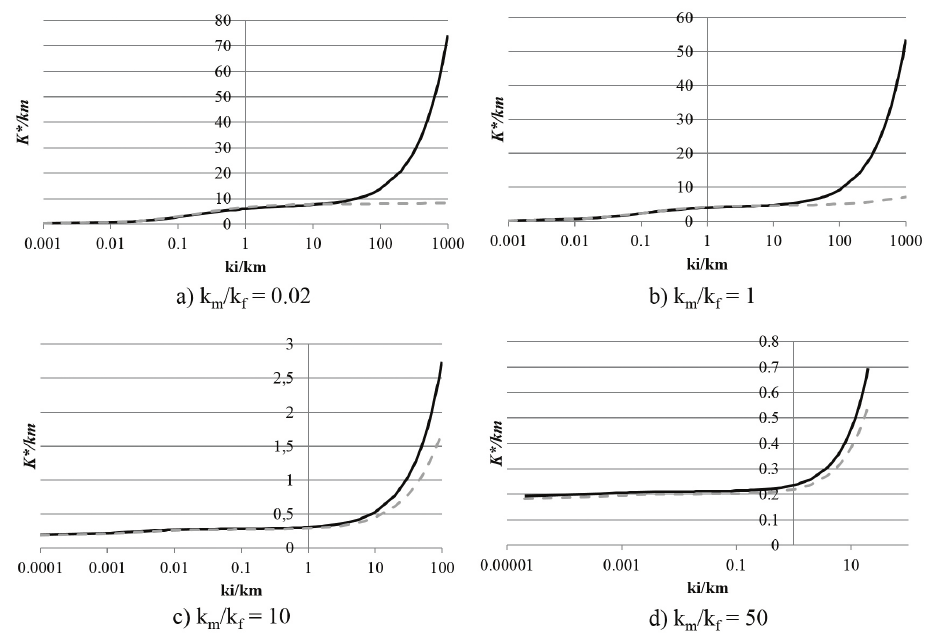
Figure 13. Effective thermal conductivity versus interphase thermal conductivity for imperfect/perfect interfaces and v lines - imperfect interfaces; dashed lines - perfect